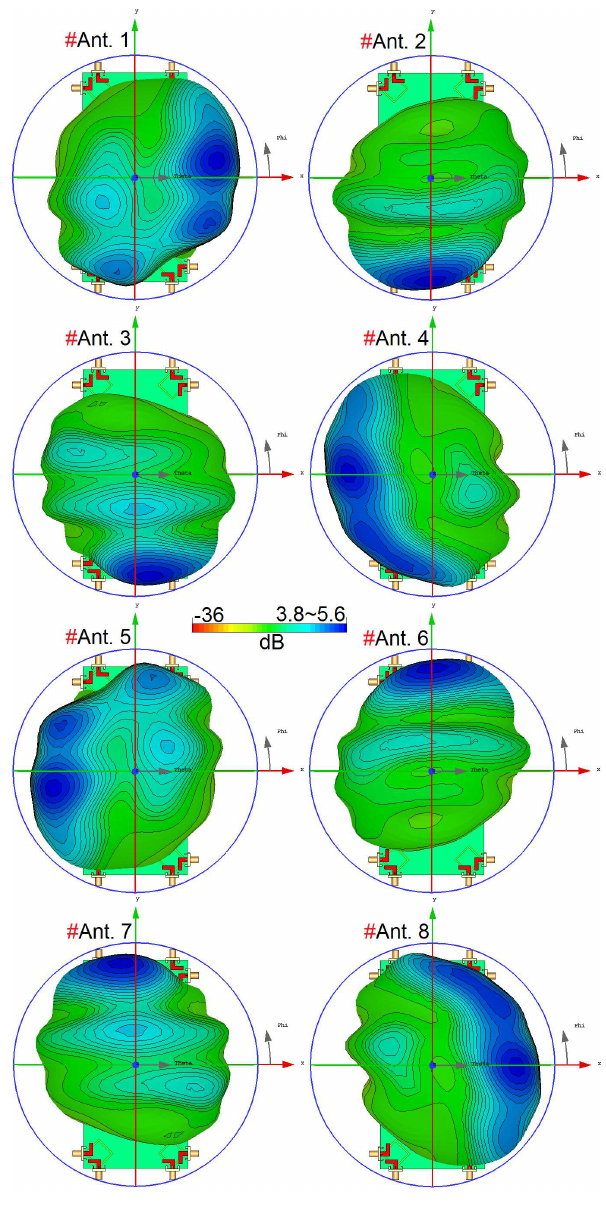
Figure 12. 3D radiation patterns of the fifth generation (5G) mobile-phone antenna.